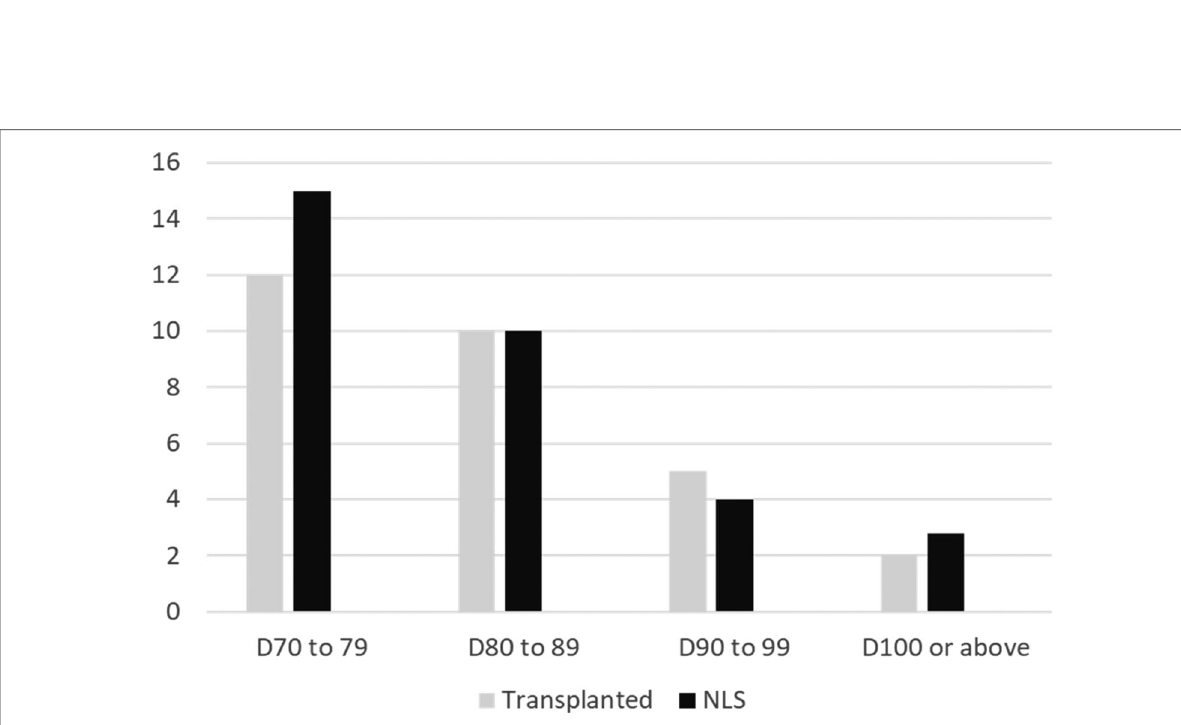
FIGURE 2 Comparison of native liver survivors and transplanted patients in different age groups showed a progressive increase in the proportion of patients requiring LT as the age at KPE advanced. (x axis: age at KPE; y axis: number of